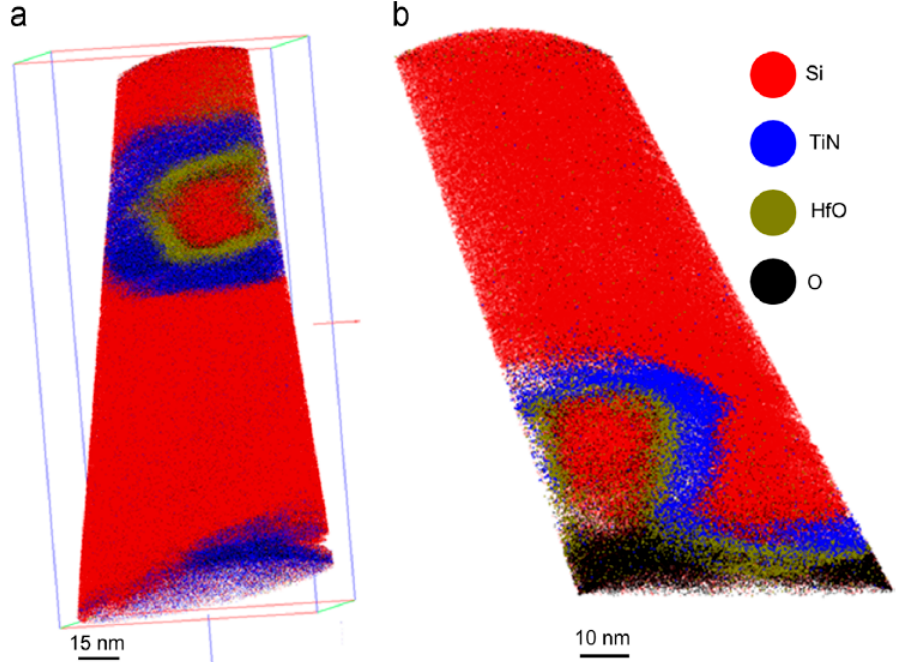
Figure 36. 3D APT volume based on the standard reconstruction algorithm after density correction of GAA ( a ) and tri-gate ( b ) silicon nanowire transistor [229].